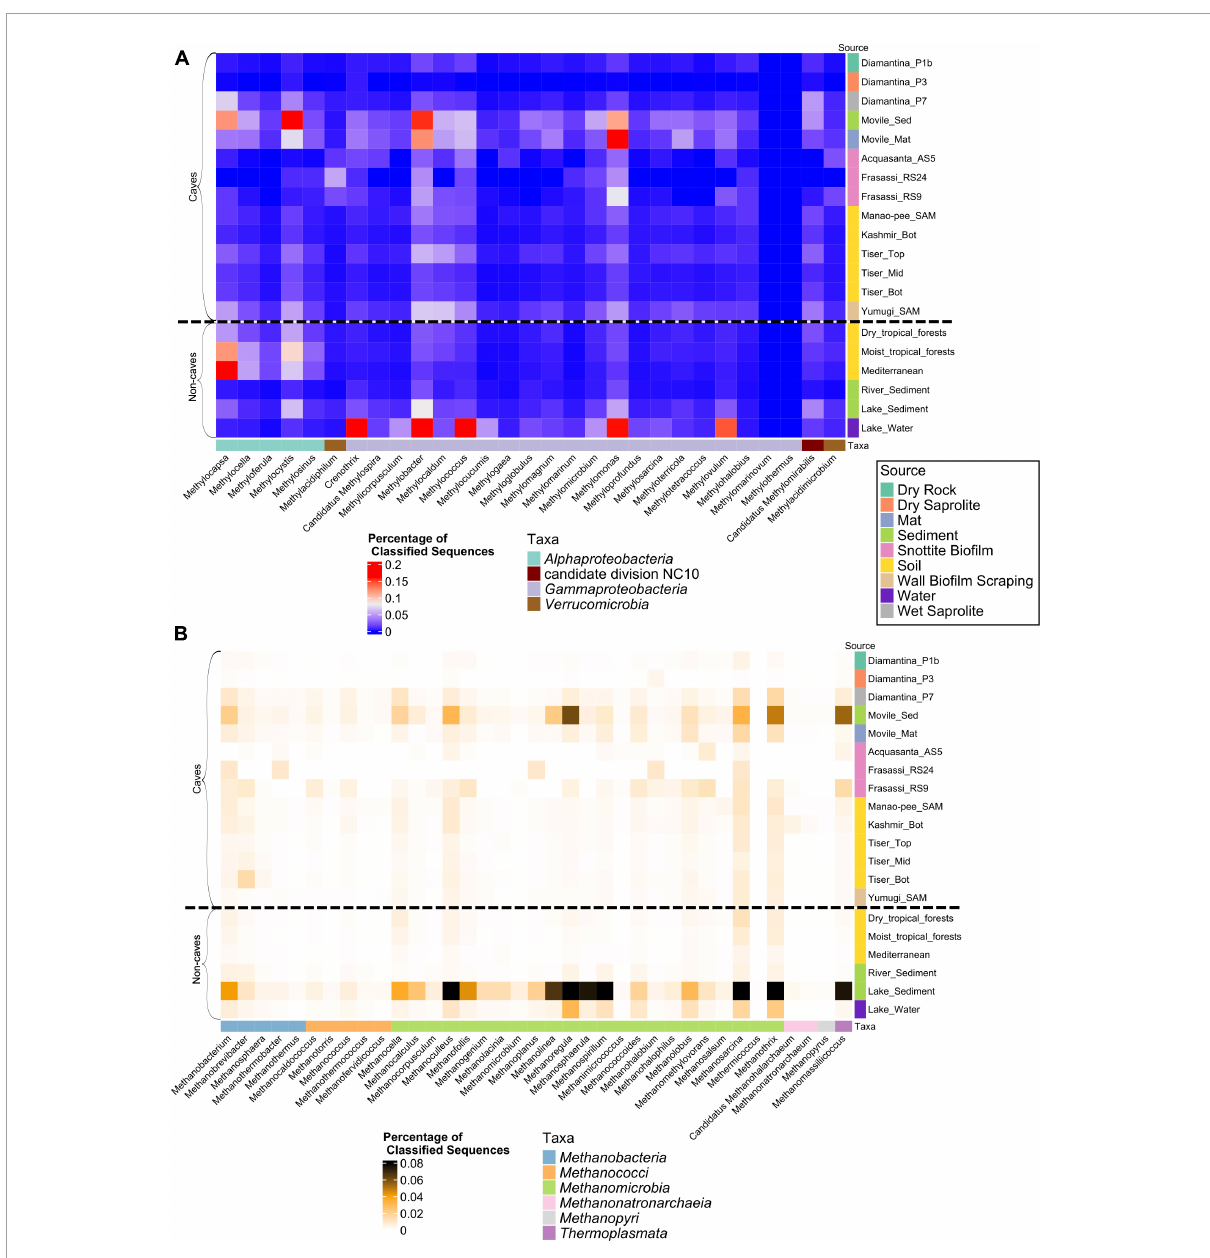
FIGURE2 Heatmaps representing the relative abundance of reads classified to MOB (A) and methanogen genera (B) . Sequencing read classification was carried out using Kaiju against the NCBI non-redundant (nr) protein database. MOB and methanogen taxa were retrieved from Kaiju output at the genus level based on a database of known MOB and methanogen genera using the NCBI taxa names. Values shown are percentage of classified sequences for the respective metagenome ( Supplementary Table 2A